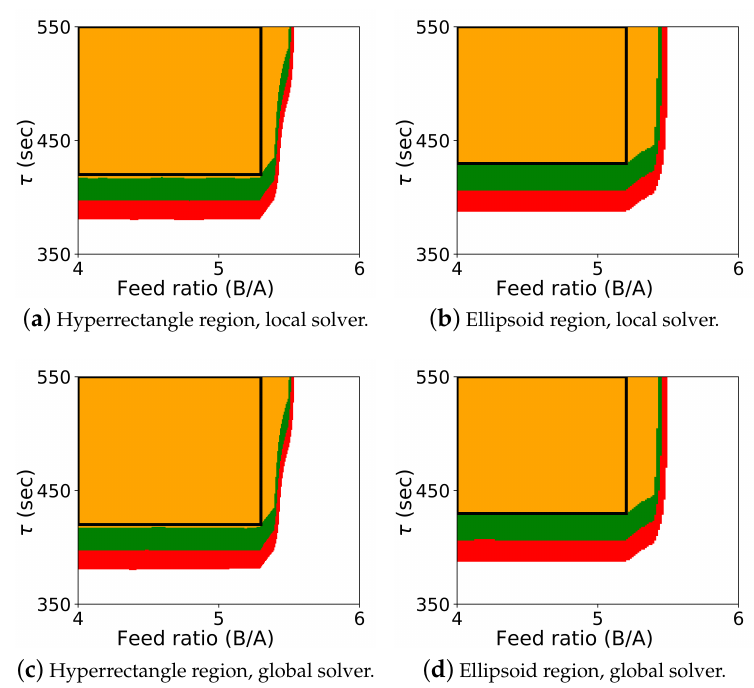
Figure 2. Probabilistic design space for case study 1 using the flexibility approaches. The colors (orange: p ≥ 0.85; green: 0.7 ≤ p < 0.85; red: 0.5 ≤ p < 0.7; white: p < 0.5) represent the probability map produced by Algorithm 2, and the black rectangle is the probabilistic design space determined by Algorithm 3 with a confidence level of